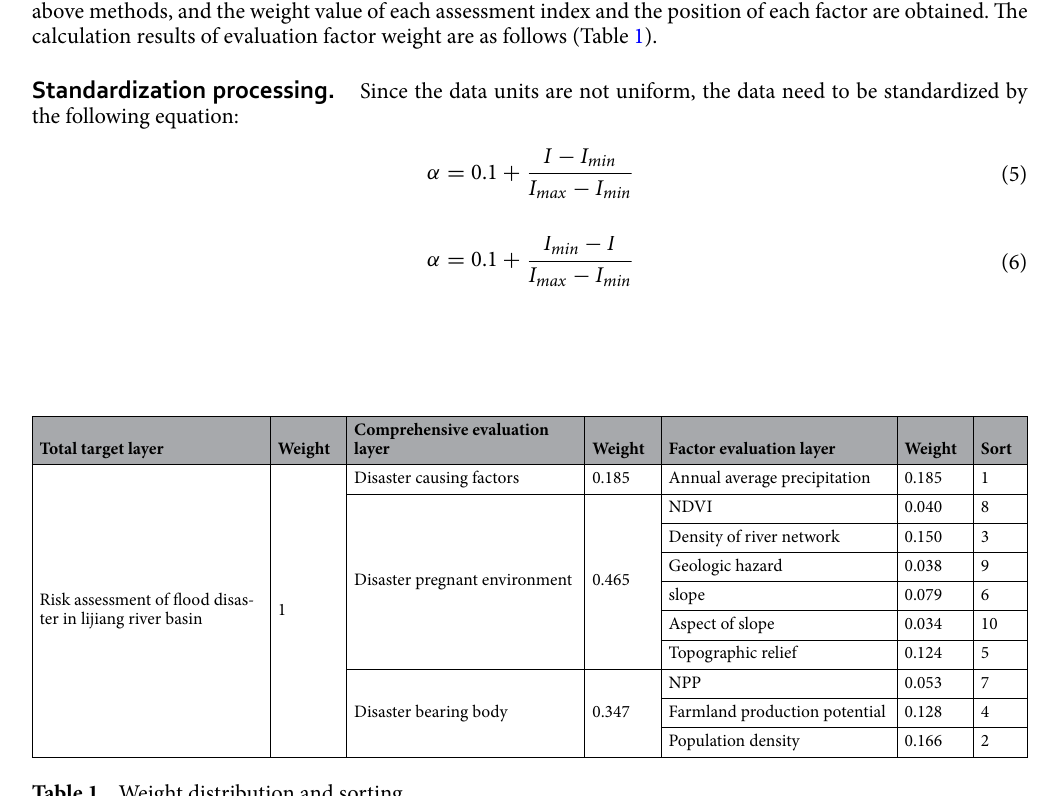
Table 1. Weight distribution and